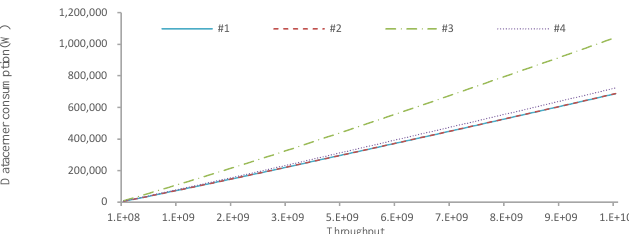
Figure 9. Total server power consumption of different data centers.